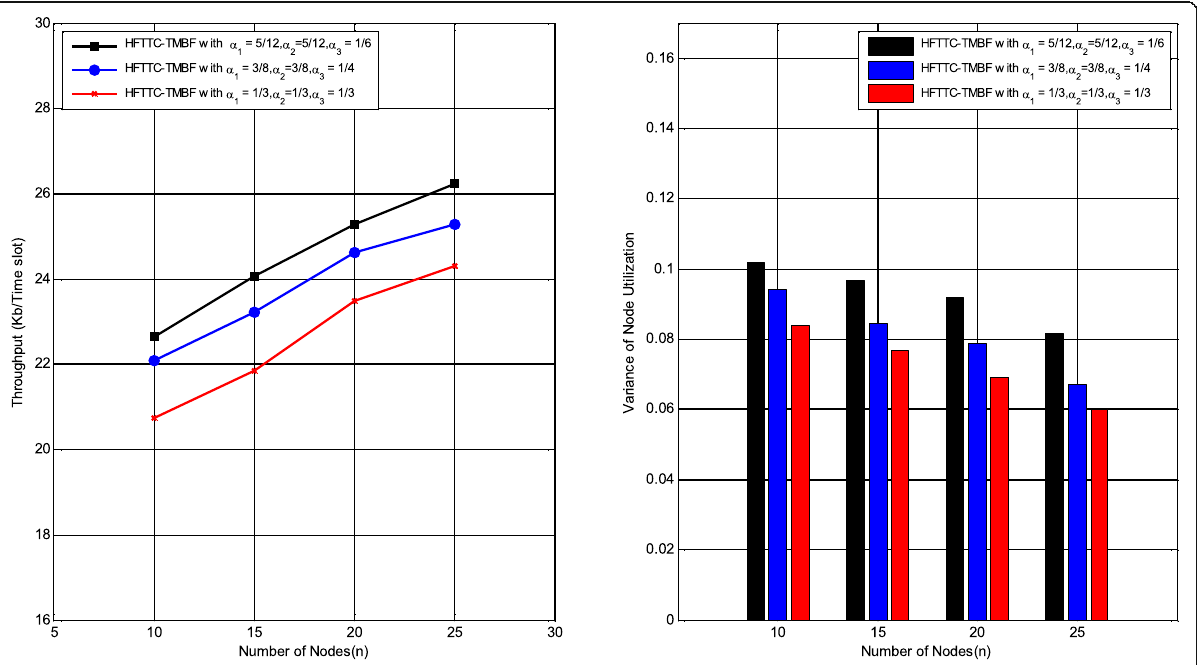
Fig. 8 Analysis of the effect of the coefficients α i from the Cost function (24) in HFTTC-TMBF on the throughput and